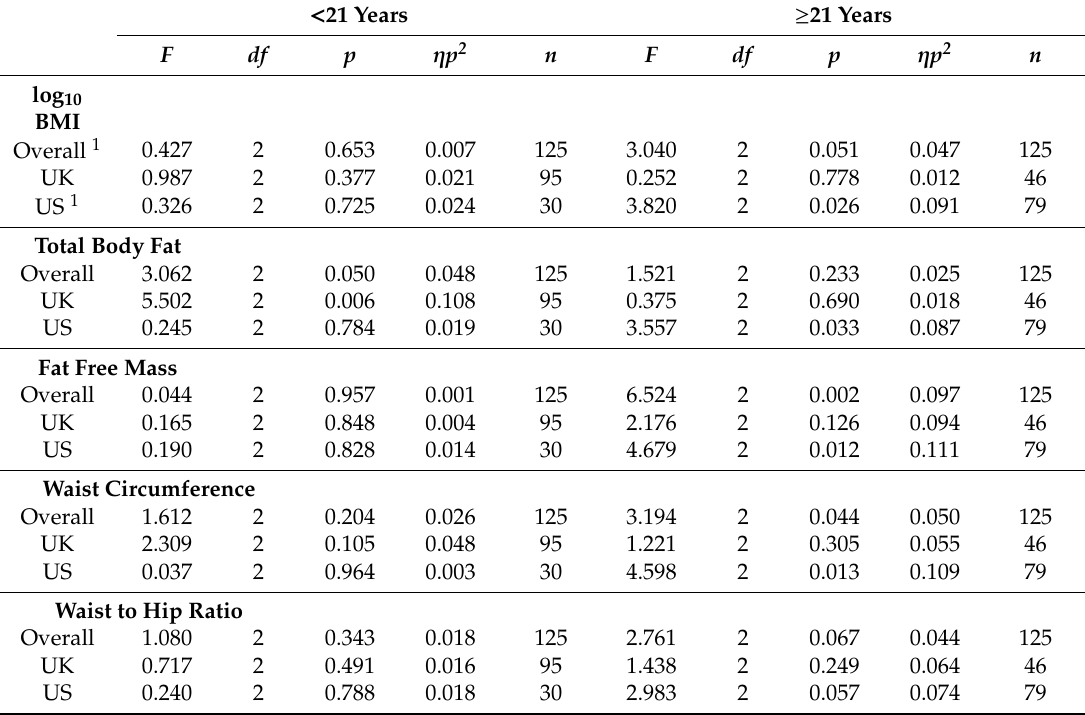
Table 1. Adjusted main e ff ects (one-way analysis of covariance) of the sweet-liking phenotype on anthropometrics per age group per country and for the entire